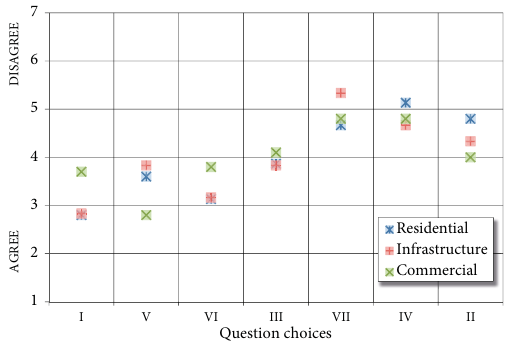
Fig. 5. The functions of marketing department based on main activity